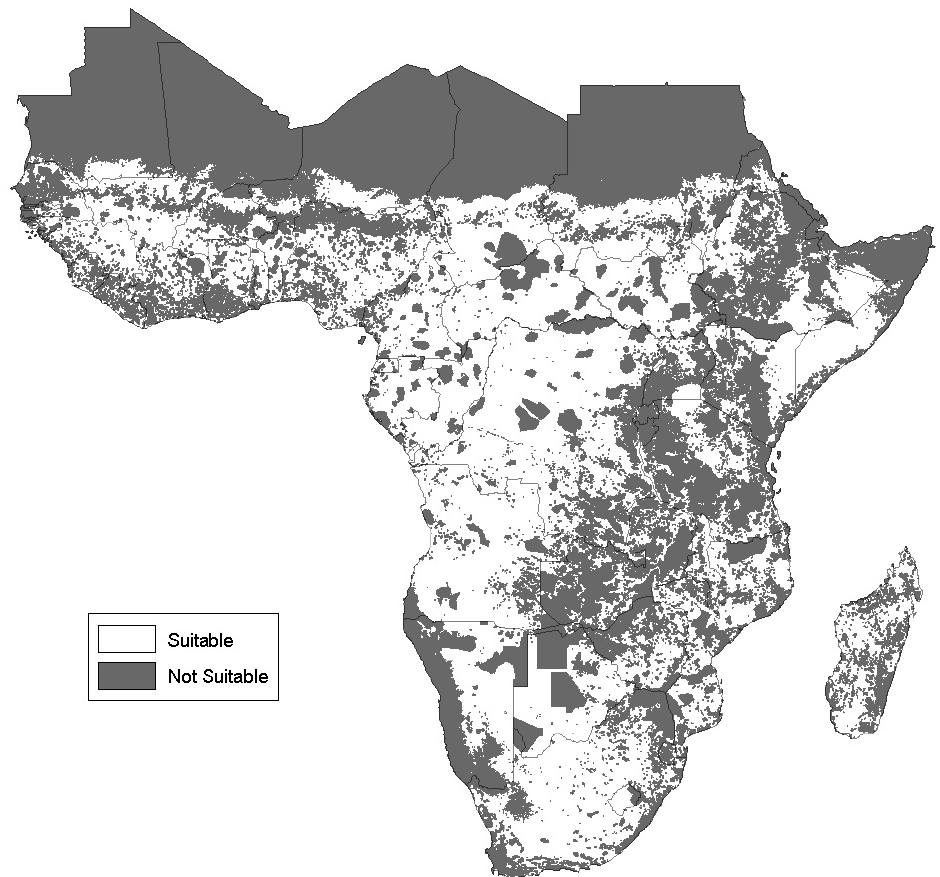
Figure 6. Overall land suitability map for small-scale hydropower deployment in Sub-Saharan Africa. Table 4. Total vs. restricted land in Sub-Saharan Africa; estimated based on the aforementioned assumptions. Power Pool.